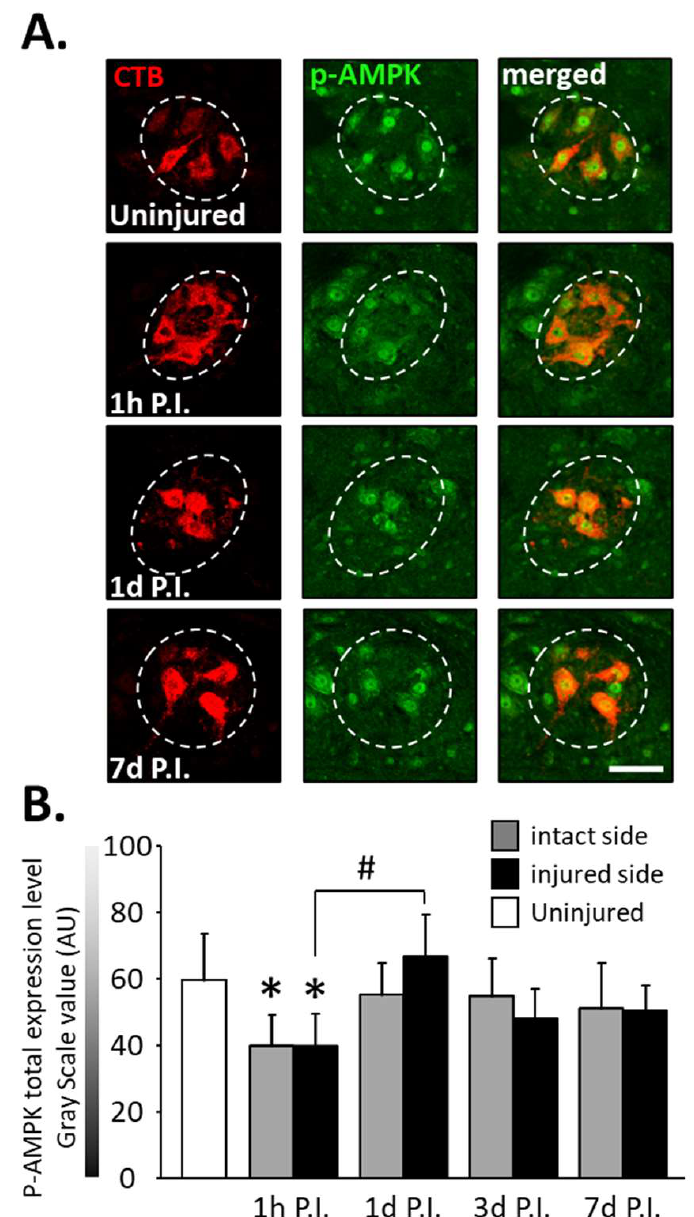
Figure 4. Phosphorylated AMPK (pAMPK) expression in phrenic motoneurons following C2 hemi- section. ( A ) Representative images showing the expression of pAMPK in phrenic motoneurons labeled with CTB in uninjured animals and in denervated phrenic motoneurons in C2 hemisected rats, 1 h, 1 d, and 7 d post-injury (P.I.). ( B ) Quantification of pAMPK in phrenic motoneurons for uninjured animals, and intact and injured sides of C2 hemisected animals 1 h, 1 d, 3 d, and 7 d following injury. # 1 d P.I. compared to 1 h P.I. for the injured side, p < 0.001. * Compared to the uninjured group, p <